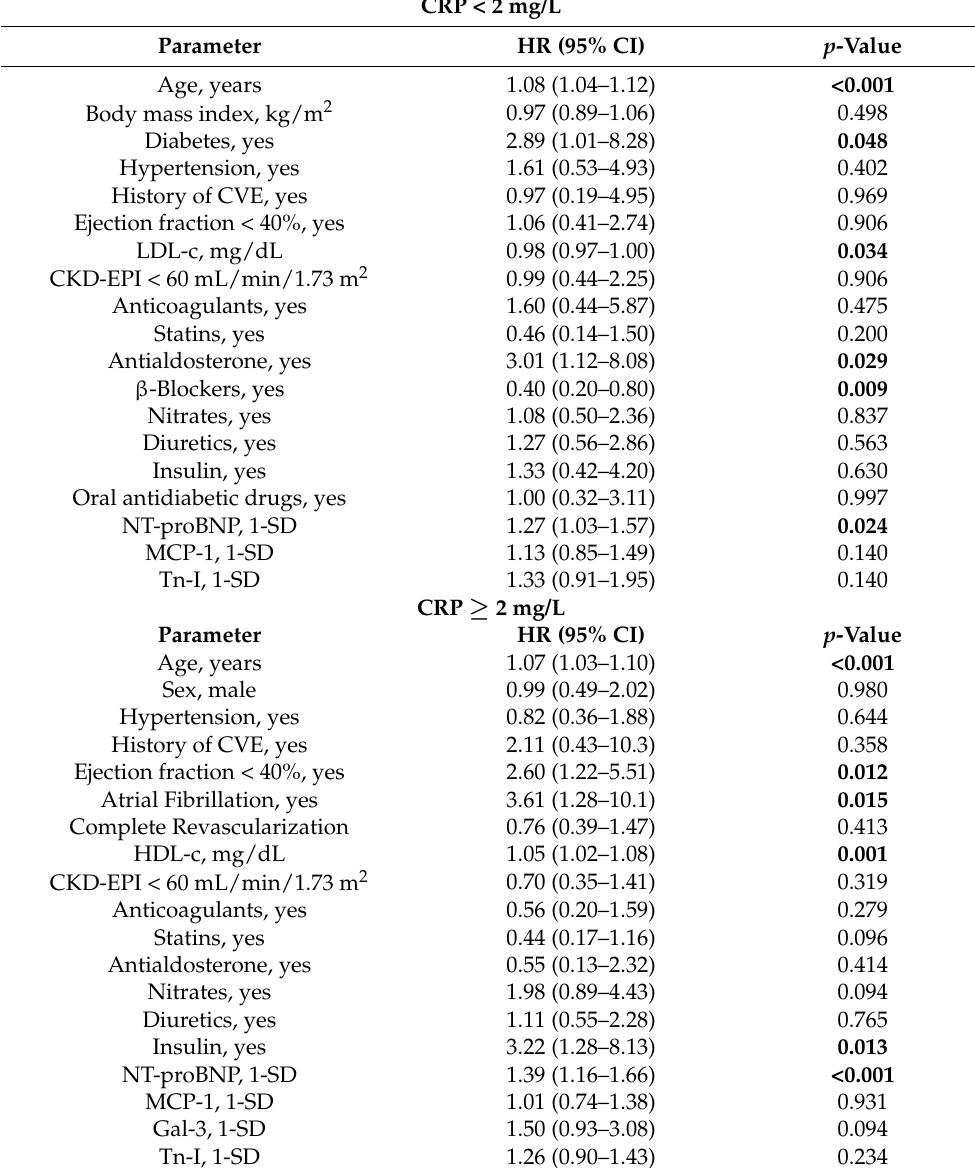
Table 4. Multivariate Cox proportional hazards model for the incidence of heart failure and